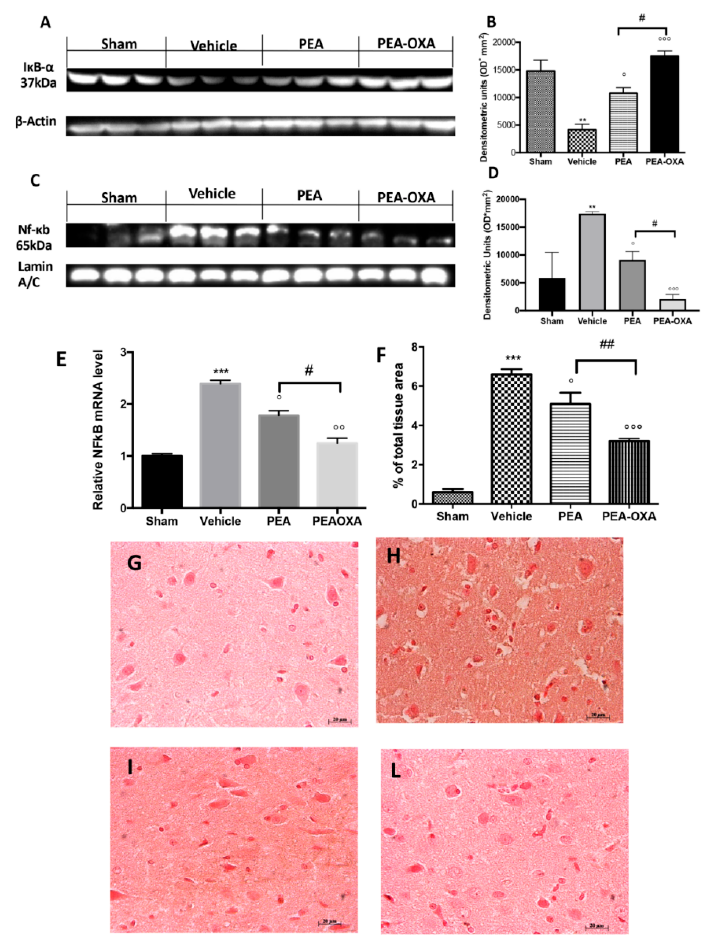
Figure 6. Efficacy of PEA-OXA on I κ B- α degradation, NF- κ B translocation, and TGF- β